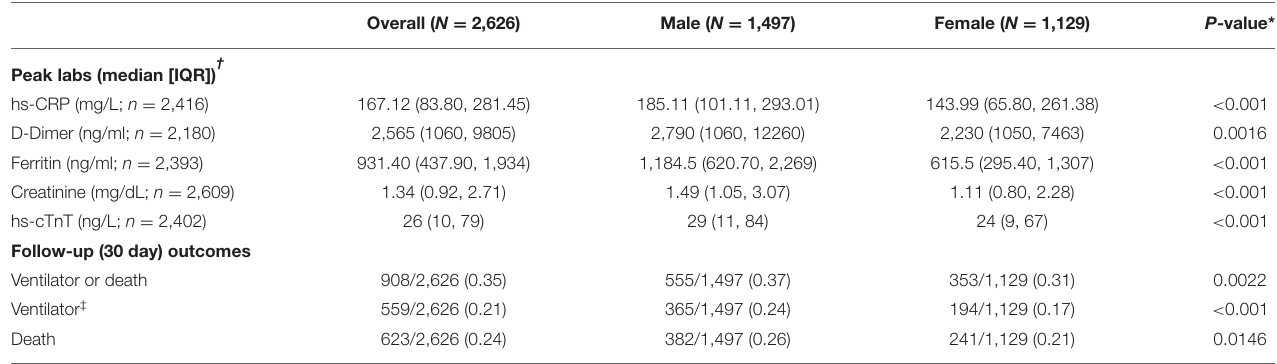
* P-values correspond to a two-sample test of proportions (for categorical variables) or Wilcoxon rank sum tests (for numeric variables) comparing corresponding characteristics of male † vs. female patients; Peak labs – high sensitivity C-reactive protein (hs-CRP), high sensitivity cardiac Troponin T (hs-cTnT) ‡ 349 patients died without being on ventilator. IQR, interquartile range; hs-CRP, high sensitivity C-reactive protein; hs-cTNT, high sensitivity cardiac Troponin T.